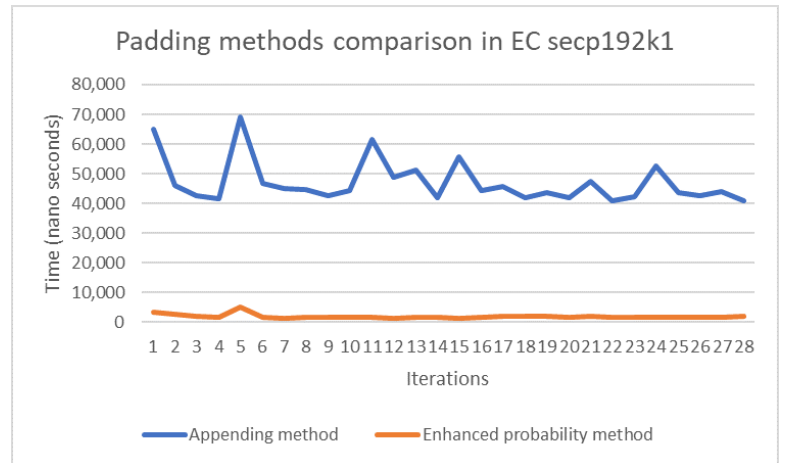
Figure 11. Performance evaluation for padding methods on secp192k1.